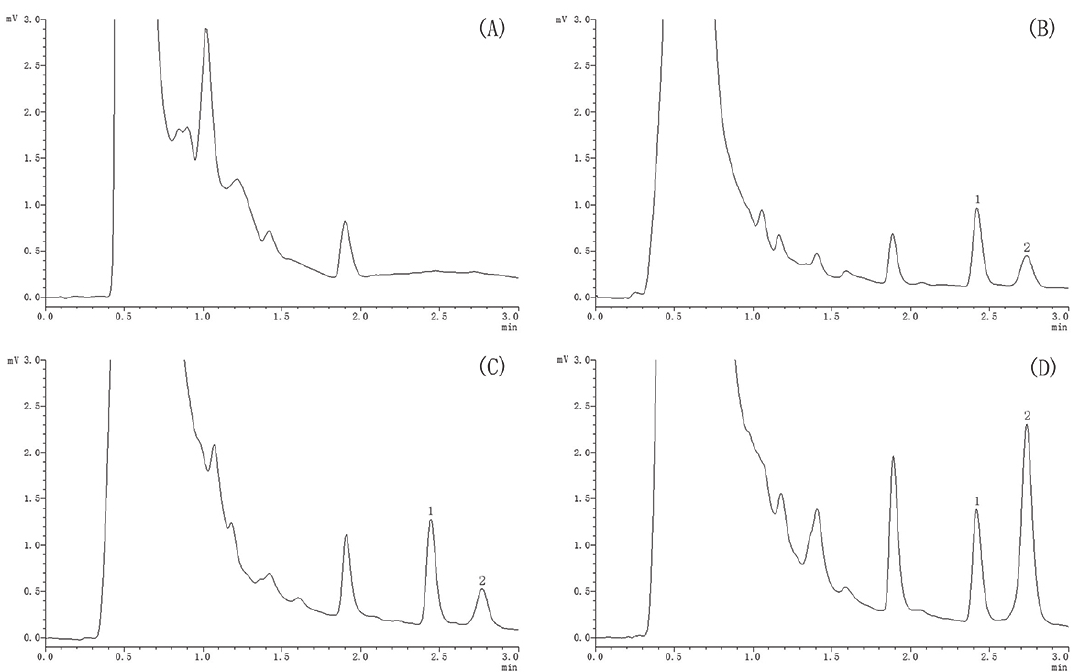
FIGURE 2 - (A) - Representative chromatogram of blank plasma. (B) - Representative chromatogram of plasma sample 20 min after the intravenous administration. (C) - Representative chromatogram of oral administration of oleracimine at a dose of 2.5 mg/kg. (D) - Representative chromatogram of plasma spiked with oleracimine and IS. Peak 1: Internal standard; Peak 2: